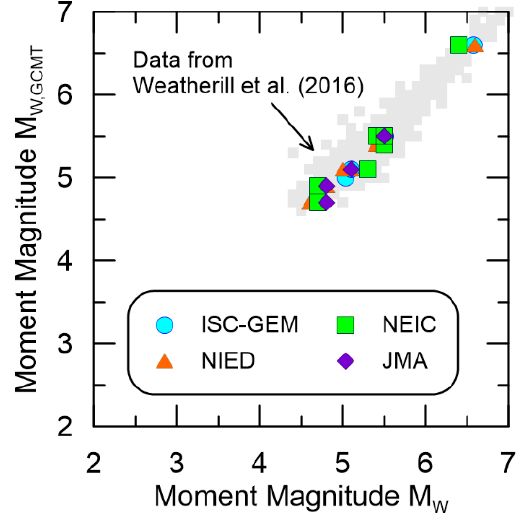
Figure 1. Relationships between M w,GCMT and M w from ISC-GEM, NIED, NEIC, and JMA. Data by Weatherill et al. (2016) from a larger earthquake compilation related to M w,GCMT versus M w.NIED is shown in gray symbols in the background for comparison